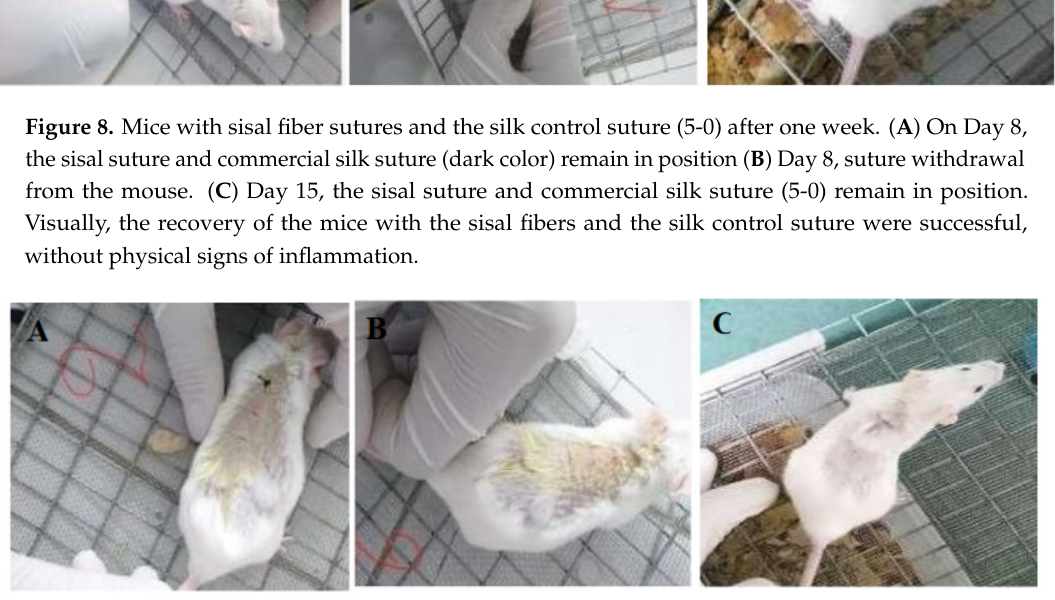
Figure 9. Mice with coconut fiber sutures and silk control suture (2-0,3-0) after one week. ( A ) Day 8, the coconut suture and commercial silk suture remain in position. ( B ) Day 8, suture withdrawal from the mouse. ( C ) Day 15, the coconut suture and commercial silk (2-0, 3-0) remain in position. Visually, the recovery of the mice with the coconut fibers and the silk control were successful, without physical signs of inflammation. Both coconut and sisal fibers have a healing behavior visually similar to their silk control.